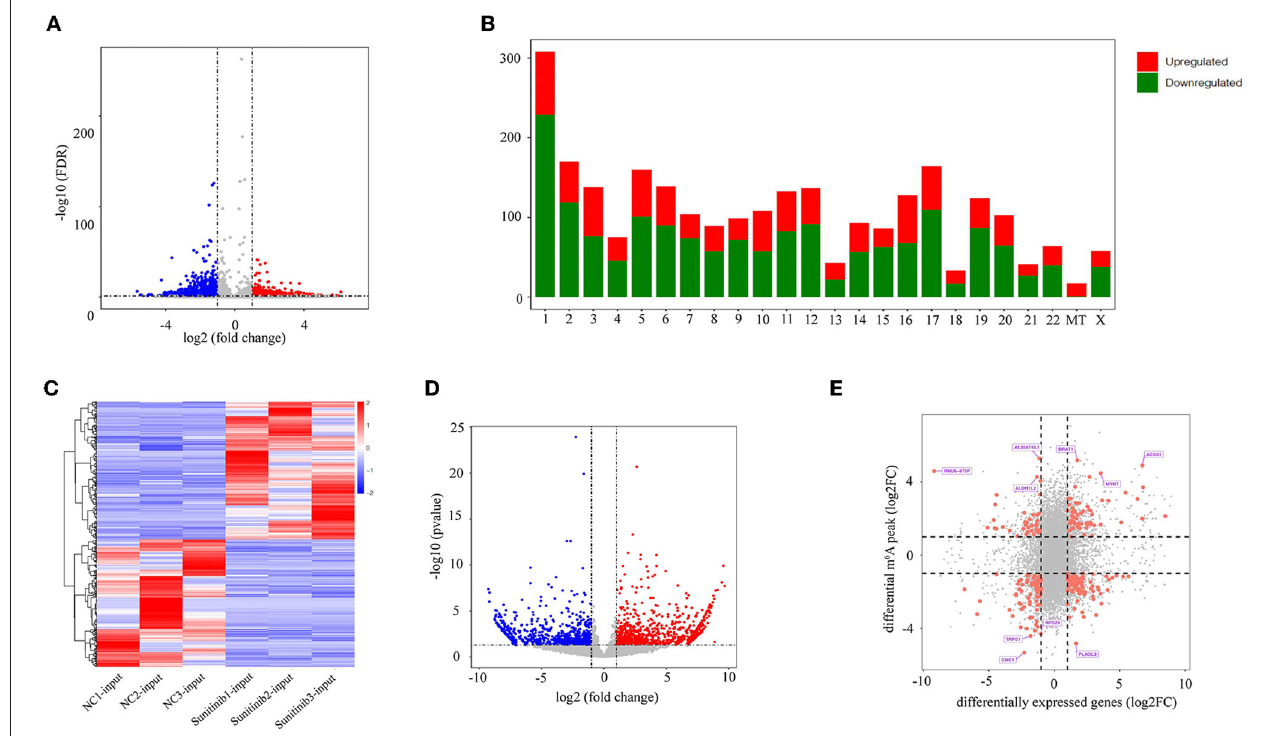
FIGURE 3 | Joint analysis of methylated RNA immunoprecipitation sequencing (MeRIP-seq) and RNA sequencing (RNA-seq) data. (A) The volcano plot shows the difference in m 6 A methylation peaks, fold changes ≥ 2, and p -values < 0.05. The red image represents the high methylation peak of m 6 A and the blue image represents the low methylation peak of m 6 A. (B) The histogram shows the distribution of the m 6 A peak on chromosomes. (C) Heatmap showing upregulated and downregulated mRNAs. (D) The volcano map shows differentially expressed genes, p -value < 0.05, and double change ≥ 2. The red area represents upregulated genes and the blue area represents downregulated genes. (E) Four-quadrant diagram showing the relationship between mRNA m 6 A methylation and mRNA